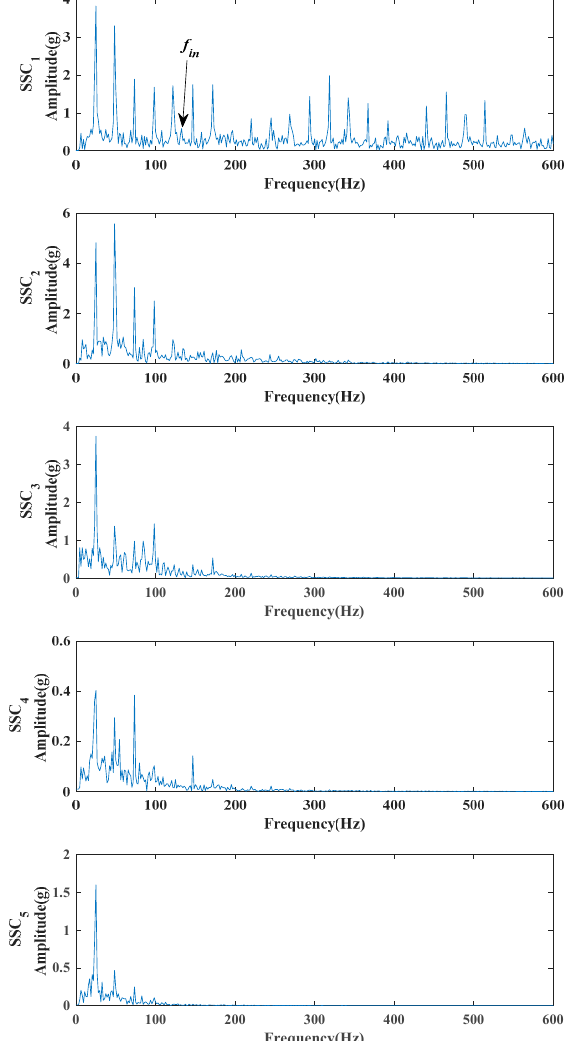
Figure 17. SSD decomposing results of the experimental inner race fault signal. Then the experimental signal was processed by using the SK method. According to the SK kurtogram in Figure 18a, the optimal filtering frequency band was at level 5.5 and the center frequency was 2800 Hz. The envelope spectrum of the filtered signal by the constructed filter is displayed in Figure 18b. As indicated in Figure 18b, a lot of periodic impacts could be seen in the envelope spectrum, and their interval was about 24.5 Hz. Such an interval corresponds to the rotating frequency, but not the fault frequency. Compared with the two widely used diagnosis methods, IMACMD obtained the most satisfying analysis results and had the advantage in the single bearing damage judgment.